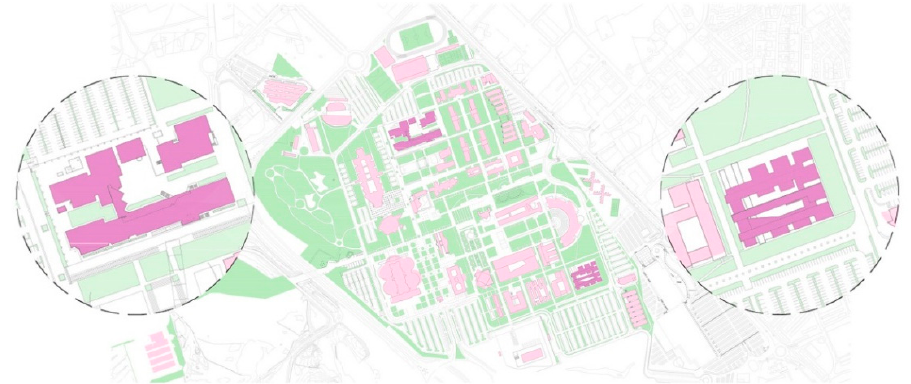
Figure 3. University of Alicante campus site plan with FS and HPS IV highlighted. Drawing: Carlos Pastor Garc í